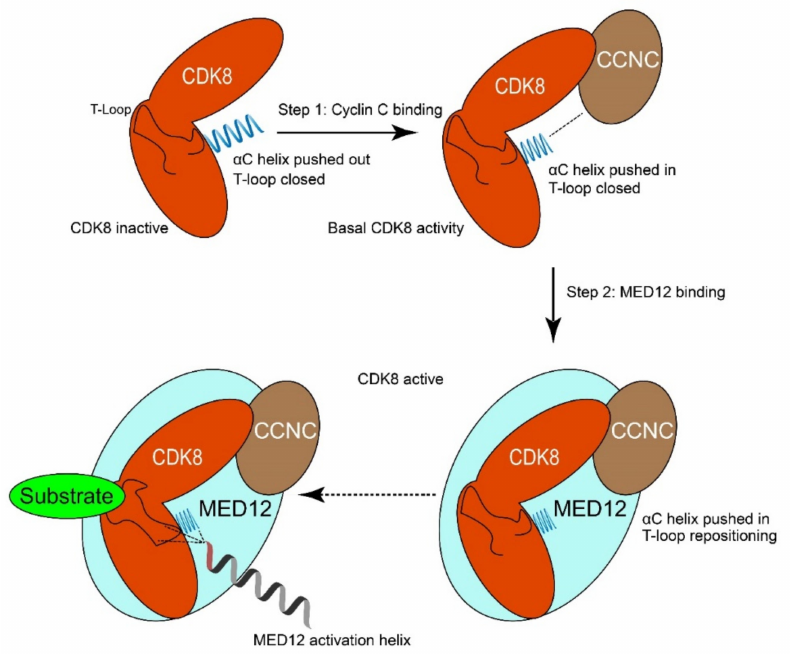
Figure 3. Model of how MED12 activates CDK8. Step 1: Cyclin C binds to CDK8 and pushes the α C-helix of CDK8 into the “pushed-in” conformation. This binding event is crucial for the formation of the active site of CDK8 and results in basal kinase activity. Step 2: MED12 binding to CDK8/CCNC stabilizes and activates the MED12-CCNC-CDK8 complex. In particular, an activation helix in MED12 contacts and stabilizes the T-loop of CDK8, thereby activating the kinase. Moreover, MED12 binding favors remodeling of the active site of CDK8 to enhance its activity. Adapted from Klatt et al. [13]. The LCEWAV domain (amino acid residues 289–757) is located between the MED12 and PQL domains. The domain name is derived from a conserved sequence motif